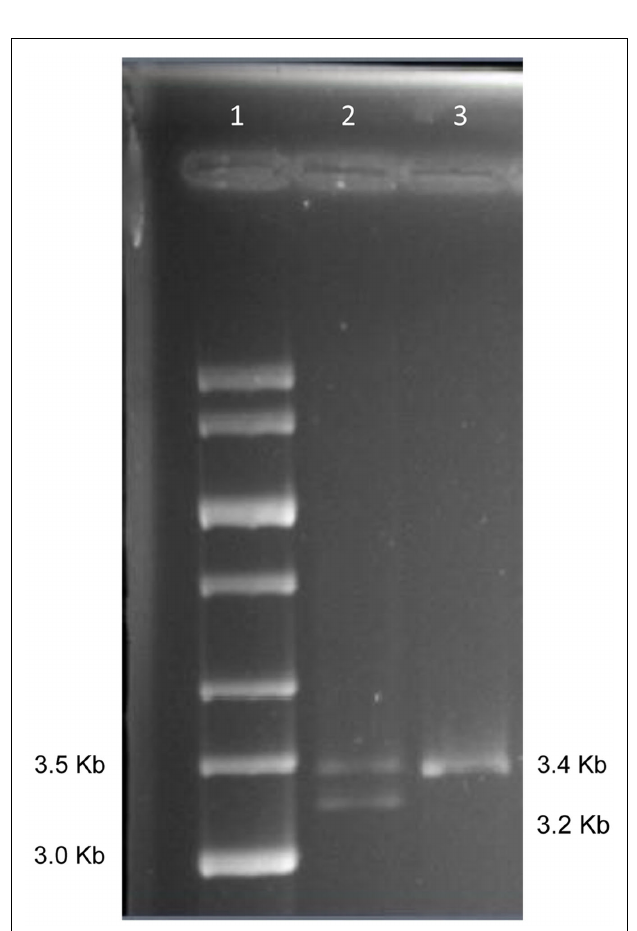
FIGURE 2 | Gel separation of digested and undigested Nco I fragments. Lane 1: 1kb size std.; Lane 2: Nco I digest of PCR from subject 1; Lane